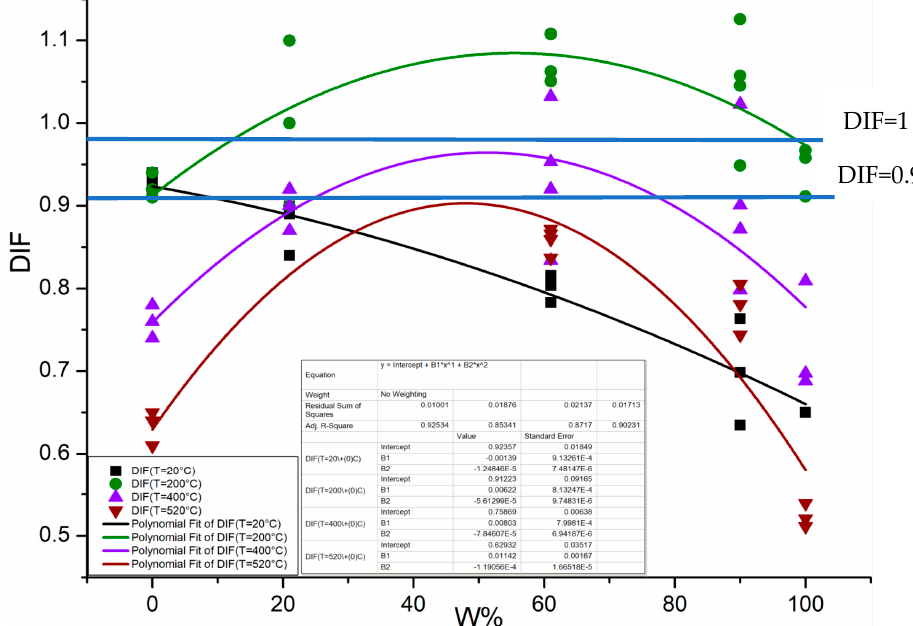
Figure 9. Curve of the heat–moisture coupling effect factor DIF of concrete compression strength versus relative water absorption ratio W ab .